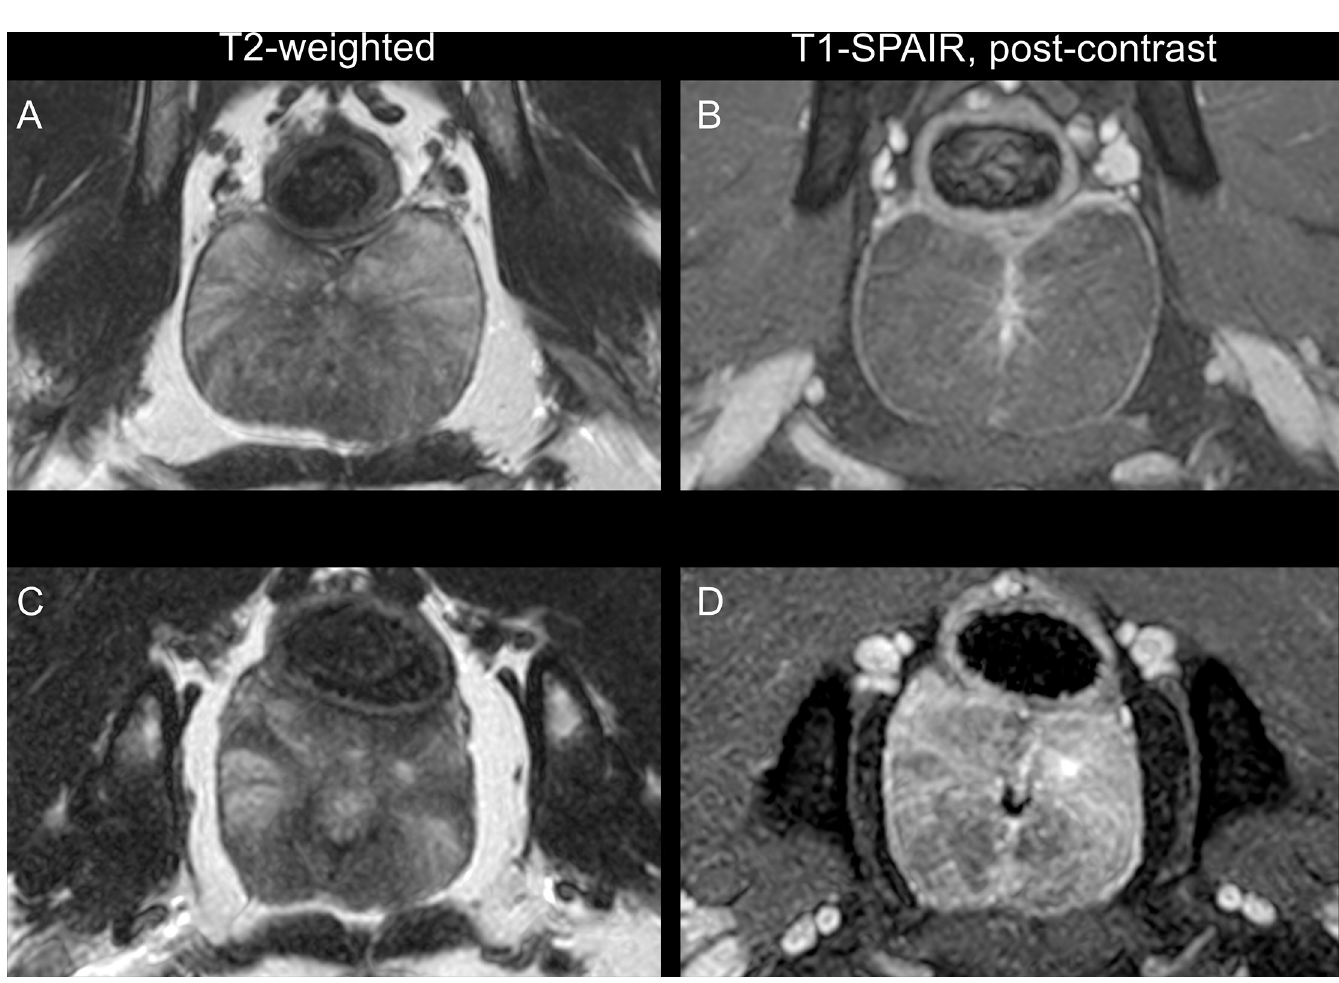
Fig 4. Transverse T2-weighted (T2W) and T1-SPAIR images of the prostate gland of a 6 years-old healthy beagle, before (A and B) and 4 weeks after intraprostatic steam application (C and D). Before intraprostatic steam application, the prostate displays a mild homogeneous hyperintense radiating pattern in T2W and a homogeneous appearance isointense to the muscle with no contrast enhancement in T1-SPAIR sequences, consistent with normal canine MRI appearance. Four weeks post-intervention, moderate, well-defined, multifocal T2 hyperintense intraprostatic lesions are noticed (C); the lesions enhance moderately after contrast agent administration (D).